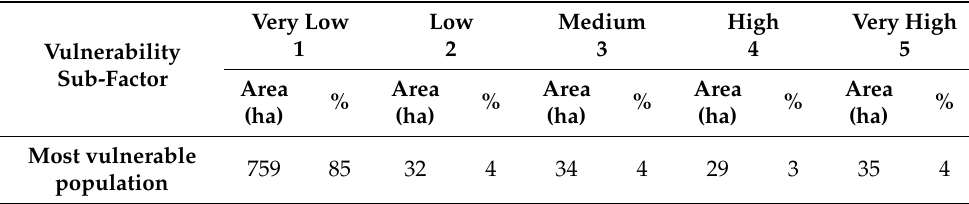
population vulnerability sub-factor.